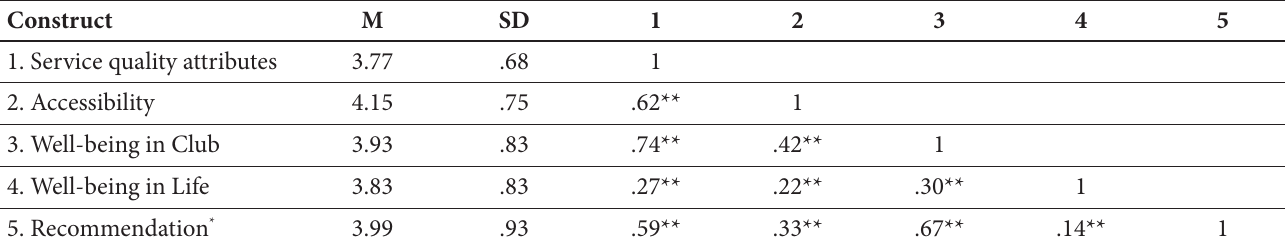
Note. ** p <.01. * Single-item